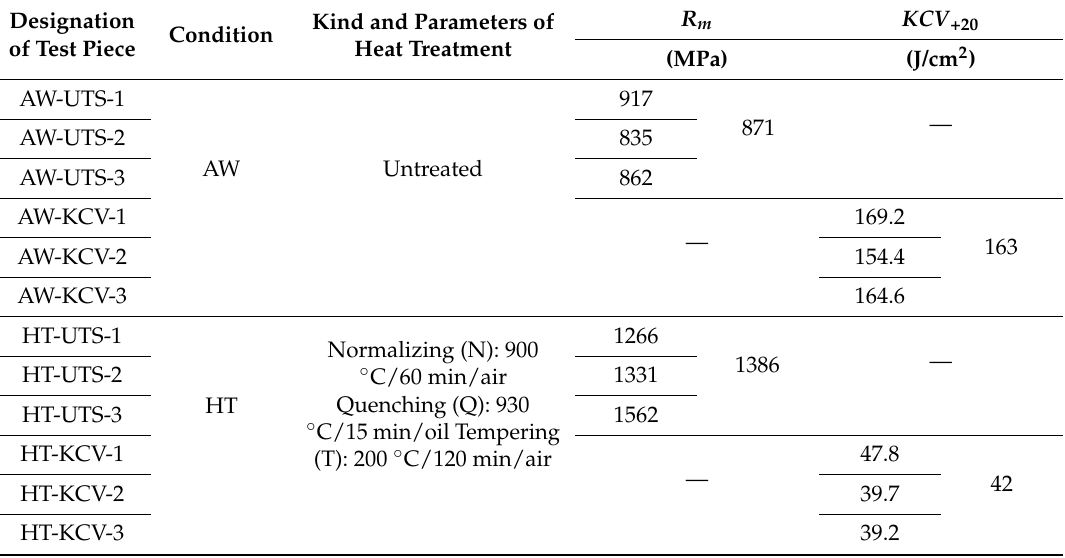
Table 5. Operations and parameters of heat treatment and selected mechanical properties of welded joints of Hardox 600: AW—after welding, HT—after post-welding heat